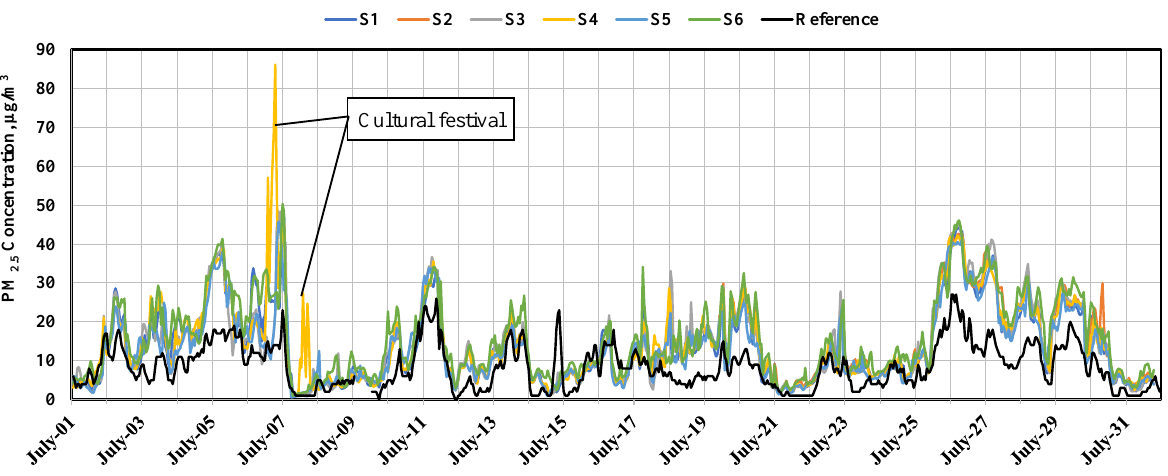
Figure 7. PM 2.5 concentrations based on AirSENCE™ and reference measurements for the month of July 2019 in the GTA Satellite Smart City, Ontario.